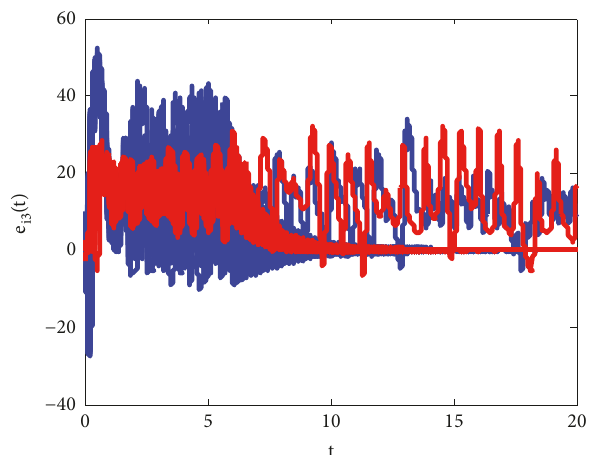
Figure 13: (Color online) More node control community network 𝑒 (𝑡) with 𝑡 𝑖3